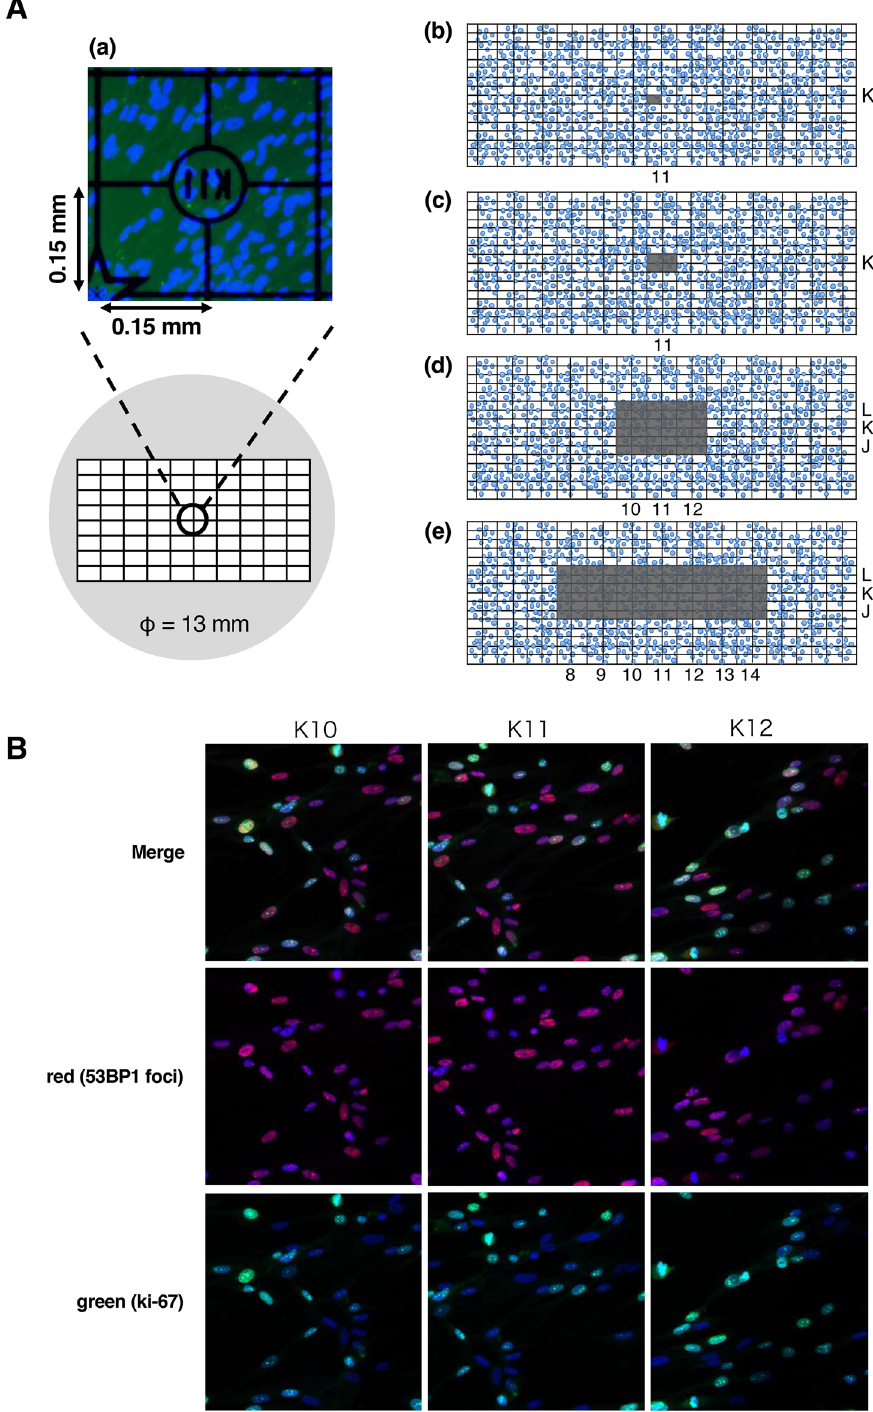
Figure 1. Schematic representation of X-ray microbeams for different field sizes and representative immunofluorescence images of 53BP1 foci and Ki-67-positive cell. ( A ) The illustration of a cover glass with grid lines and X-irradiation field sizes. The cells were cultured on a cover glass with grid lines to create the cell populations. This cover glass is a 0.15-mm grid that is engraved on the surface of the cover glass that makes it possible to confirm the irradiation field in more detail (a). X-ray microbeams were applied at 0.02 mm 2 (b), 0.09 mm 2 (c), 0.81 mm 2 (d), and 1.89 mm 2 (e) irradiation field sizes to cell populations by an X-ray microbeam generator, centering on K11 on the cover glass. Irradiation field is shown in gray. ( B ) The representative immunofluorescence image of the X-irradiated area (K11) and the non-irradiated area (K10, K12) in 0.09 mm 2 . Blue: Nuclei. Red: 53BP1 foci. Green: Ki-67-positive cells. These figures were created with PowerPoint for Mac